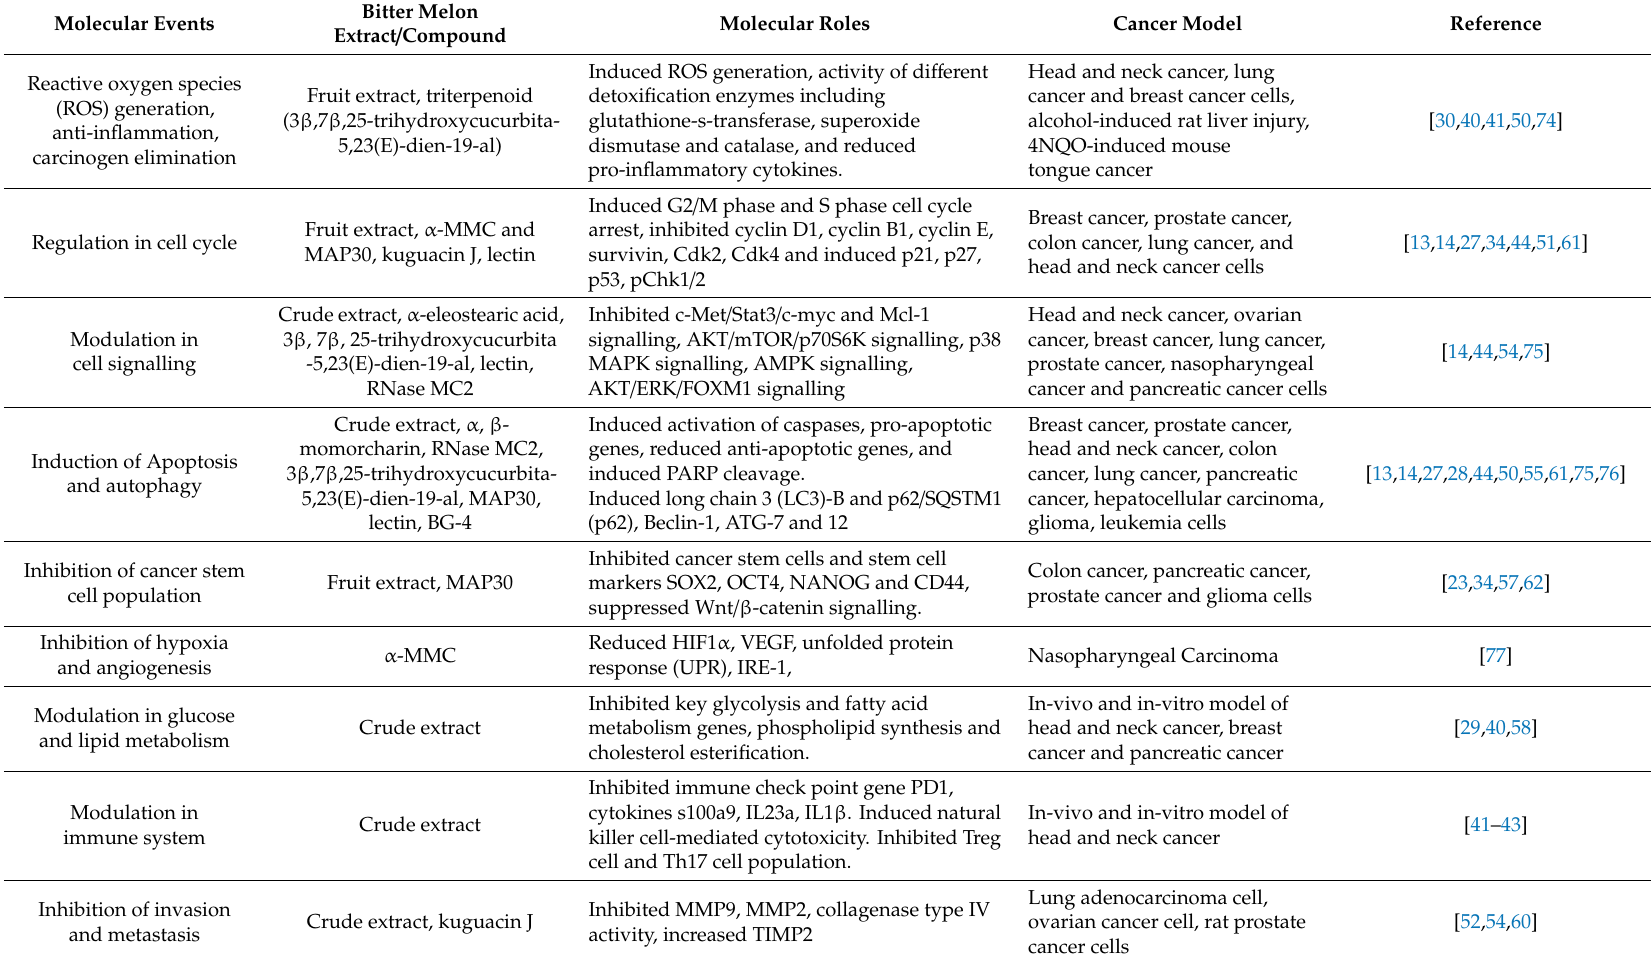
Table 2. Molecular mechanisms of bitter melon in cancer prevention and